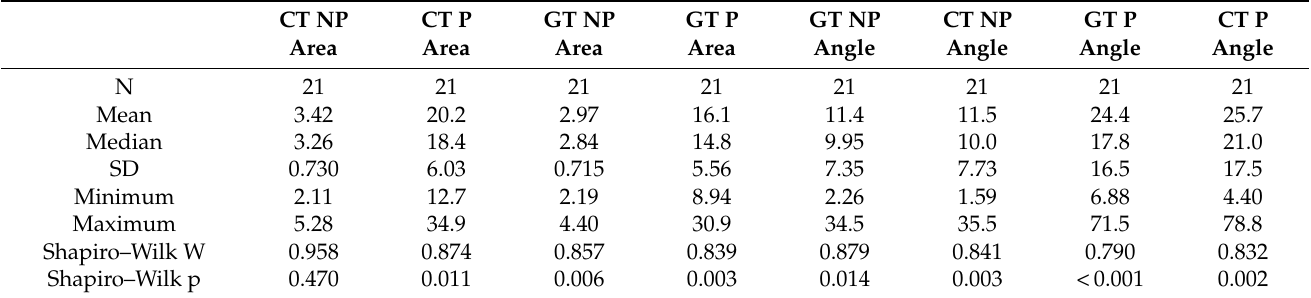
Table 1. Descriptive of Alveolar space area and the alveolar crest angle as estimated by the computer tool and the ground truth in patients with or without